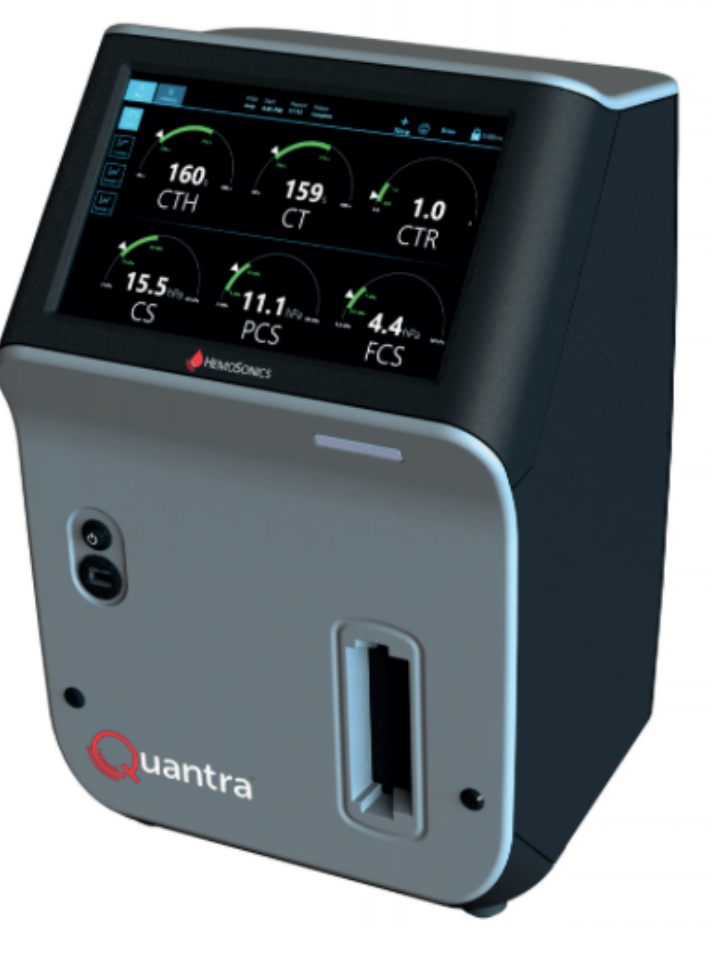
Figure 2. Principle of SEER